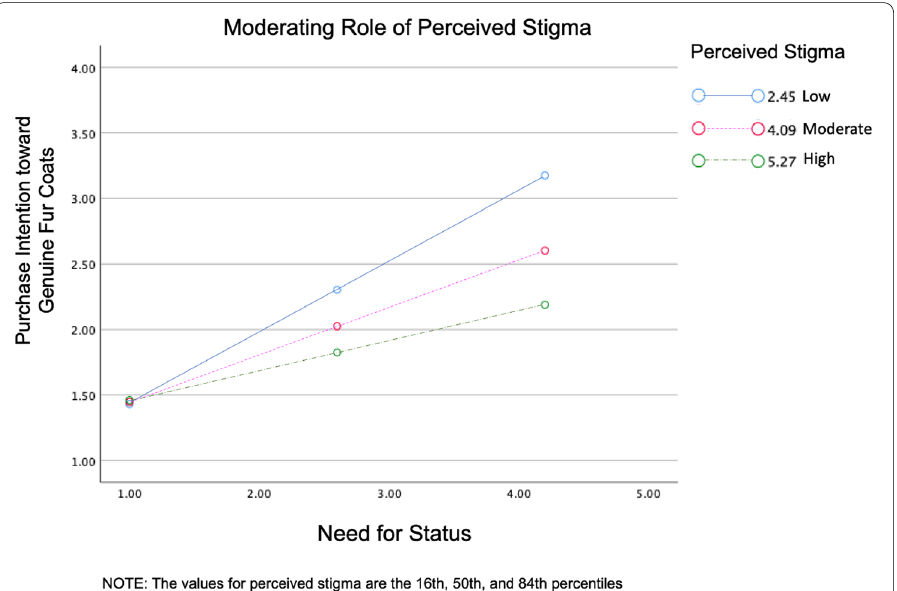
Fig. 2 Perceived stigma’s moderating effect: genuine fur